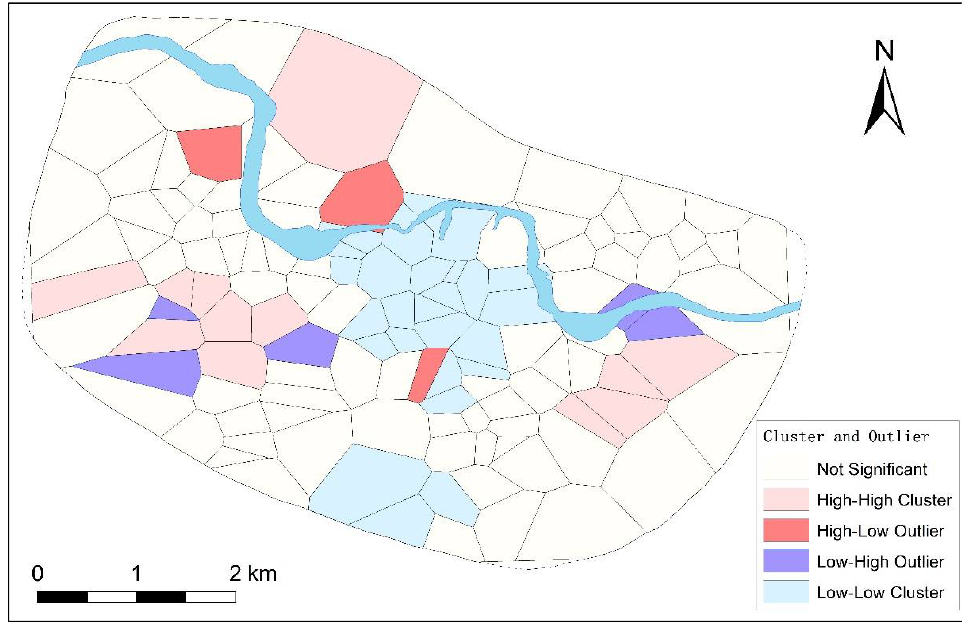
Figure 8. Cluster and outlier analysis result.